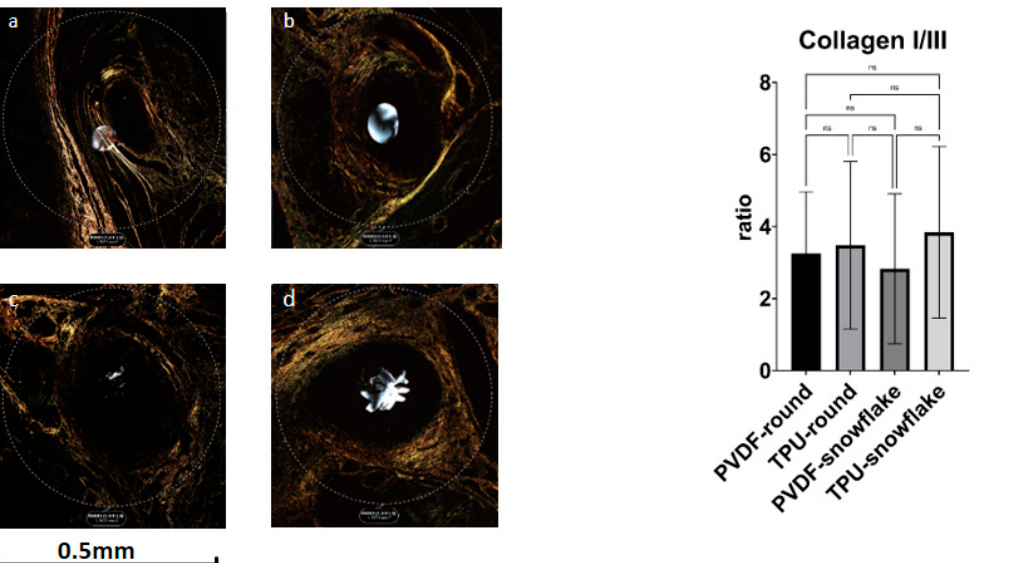
Figure 4. Cross-polarization analysis for Sirius red staining. ( a ) PVDF-round, ( b ) TPU-round, ( c ) PVDF-snowflake, ( d ) TPU-snowflake. There was no significant difference between the groups (F (3, 54) = 0.4964, p -value = 0.6863). Abbreviations: ns: not significant. Table 2. Immunohistochemical characteristics of the different threads. The Ki67 count and SMA area showed significant differences between the groups, while the collagen I/III ratio and CD68 count were not different between the groups. Abbreviations: PVDF: polyvinylidene fluoride, TPU: thermoplastic polyurethane, SD: standard derivation, SMA: smooth muscle actin. Data are repre- sented as the mean (SD).